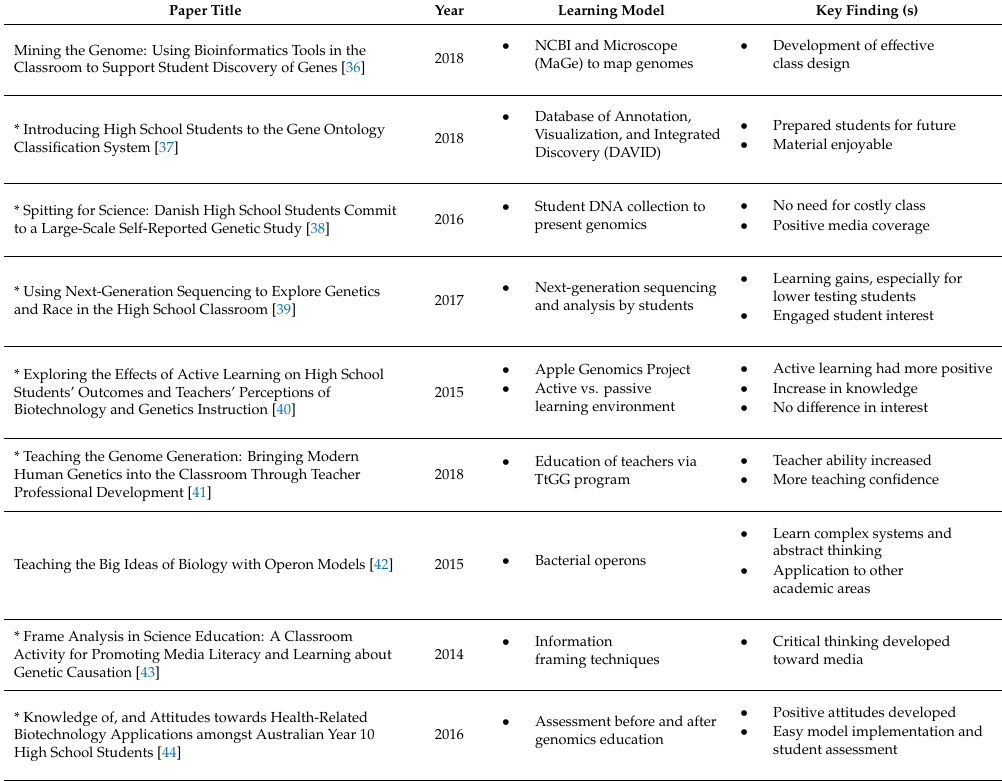
Table 1. Publications in the last five years on high school students and genomics